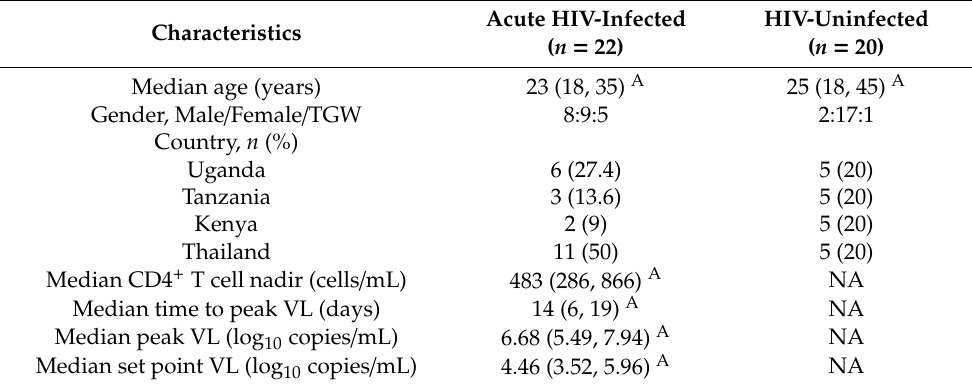
Table 1. Acute untreated (RV217) subjects’ demographics. Characteristics